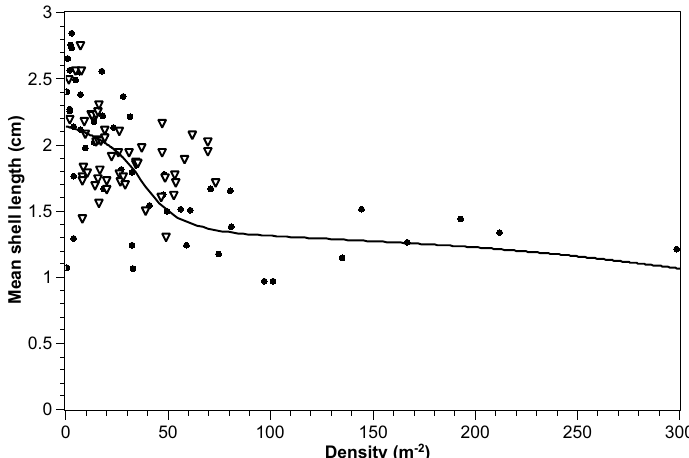
Fig. 5. Declines in mean shell length with overall density for each shore and date combination in Strangford Lough ( fi lled circles) and for the survey data of Cummins et al. (2002) from around the Irish coast (open reversed triangles). The line is derived from the size-structured model based on the transitions in Figure